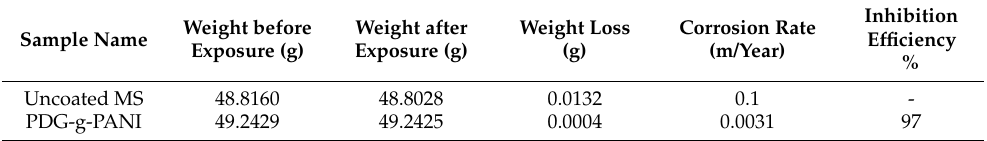
Table 8. Weight of uncoated and coated MS before and after study in open air, with a corresponding corrosion rate and inhibition efficiency of